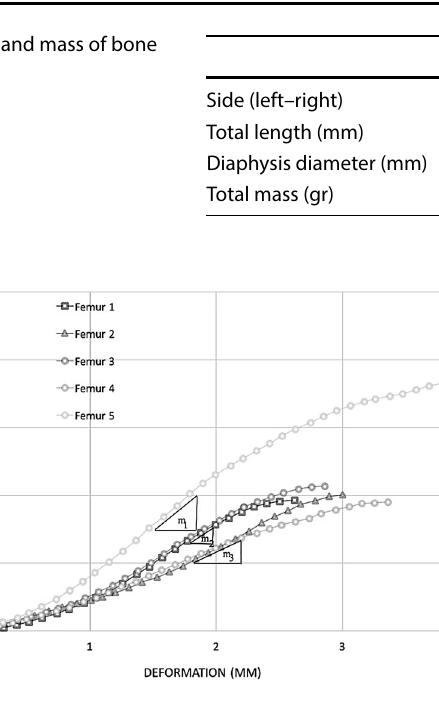
Fig. 7 Measured reaction force vs displacement values from experi- mental specimen models Fig. 8 Estimated reaction force vs displacement values obtained from the computational